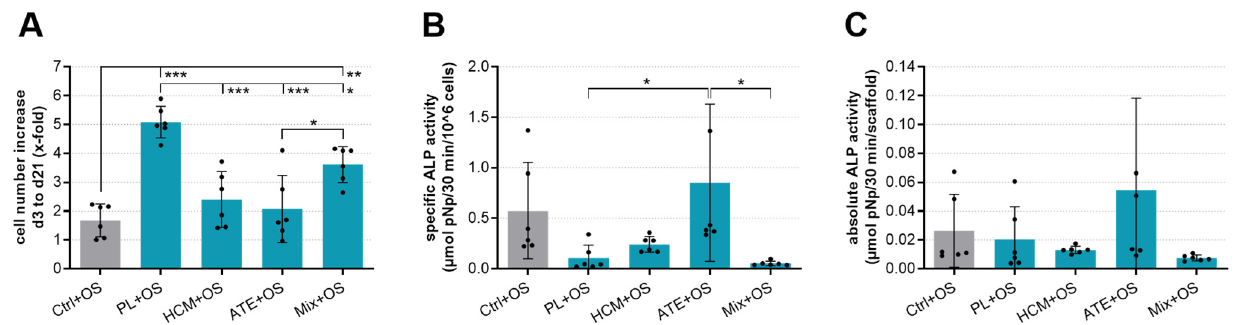
Figure 5. The cell number increase and osteogenic differentiation of hBM-MSC cultured on functionalized mineralized collage scaffolds. Cell-seeded scaffolds without bioactive factor mixture functionalization served as Ctrl (Ctrl+OS). ( A ) Cell number increase from day 3 to day 21, ( B ) specific and ( C ) absolute ALP activity after 21 days of cultivation (mean ± SD, n = 6 as represented by black dots within bars, 1-way ANOVA following Tukey’s post hoc tests: * p < 0.05, ** p < 0.01, *** p < 0.001; OS: osteogenic supplements).